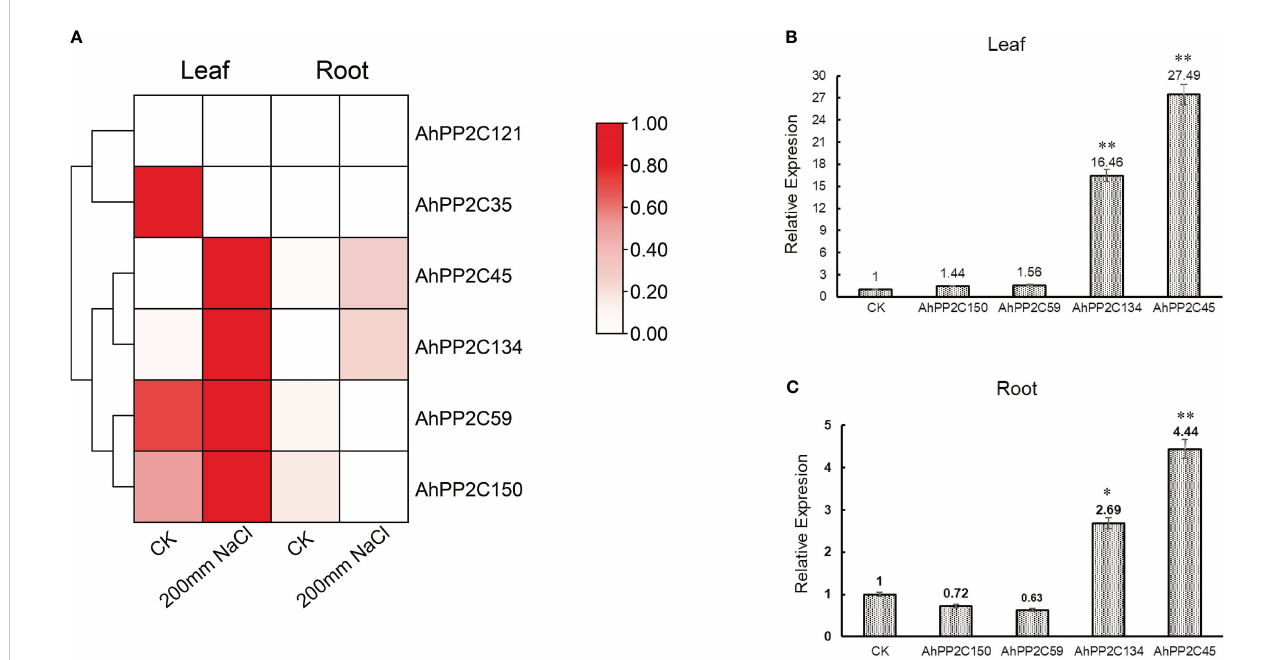
FIGURE 9 Expression pro fi les under salt stress. (A) Relative expression pattern of AhPP2C s in subclades AI and AII in response to salt stress. (B, C) qRT-PCR analysis of AhPP2C s 45 , 59 , 134 and 150 under salt stress in leaves (B) and roots (C) . “ * ” indicated that the genes were signi fi cant differences compared with the untreated control (**P<0.01,